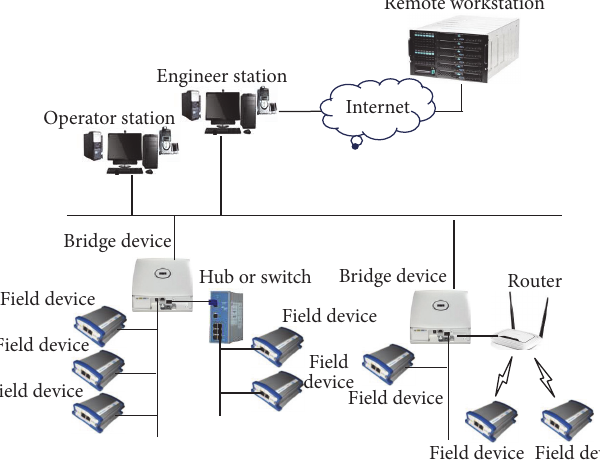
Figure 1: Typical framework of ICS (industrial control